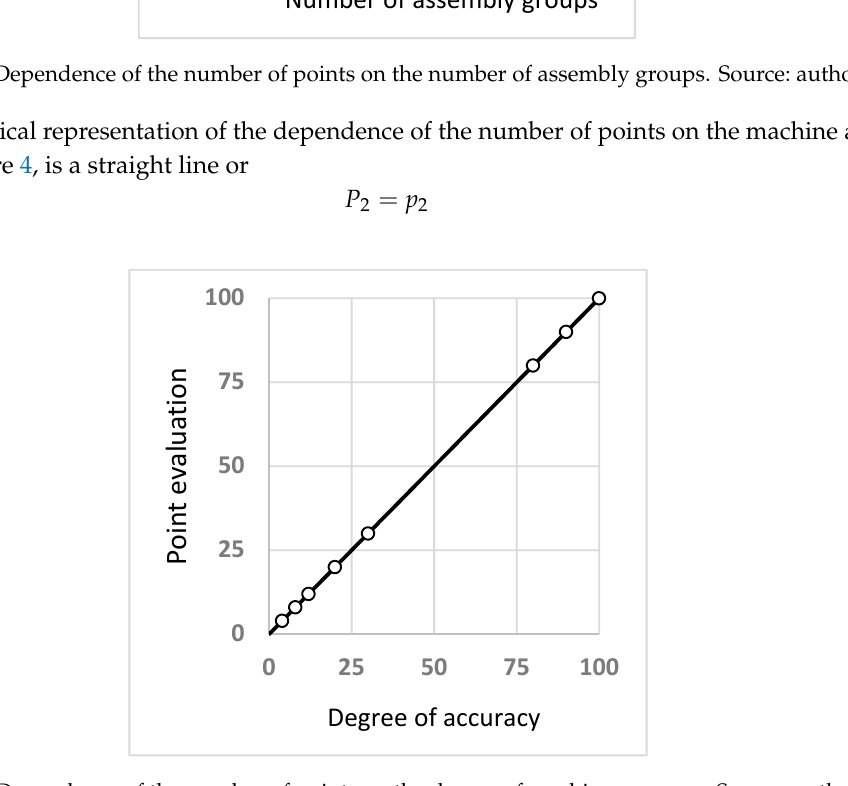
Figure 4. Dependence of the number of points on the degree of machine accuracy. Source: authors.